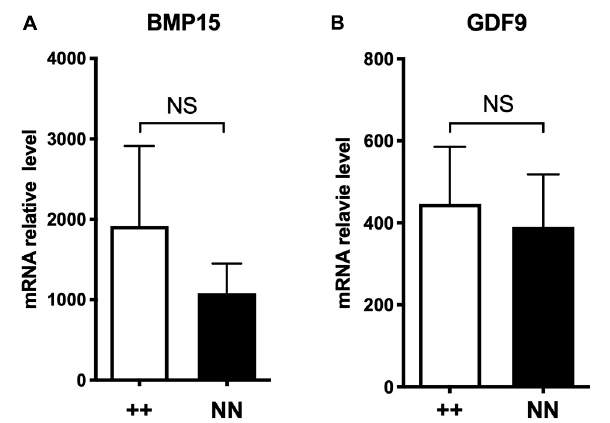
FIGURE 8 | Effect of FecX N mutation on BMP15 and GDF9 expression in ovine oocyte. Quantitative real-time PCR results of BMP15 (A) and GDF9 (B) expression in oocyte pools from growing (1–3 mm) follicles (two pools of five oocytes per animal) from homozygous FecX N carrier ( N/N , n = 5) and non-carrier ewes (+ / +, n = 5) during the follicular phase of the estrus cycle. Results are expressed as means ± SEM of the mRNA relative level for each genotype, using GAPDH and SDHA as internal references. Raw data were analyzed by two-way ANOVA. Means ( ± SEM) were not significantly different